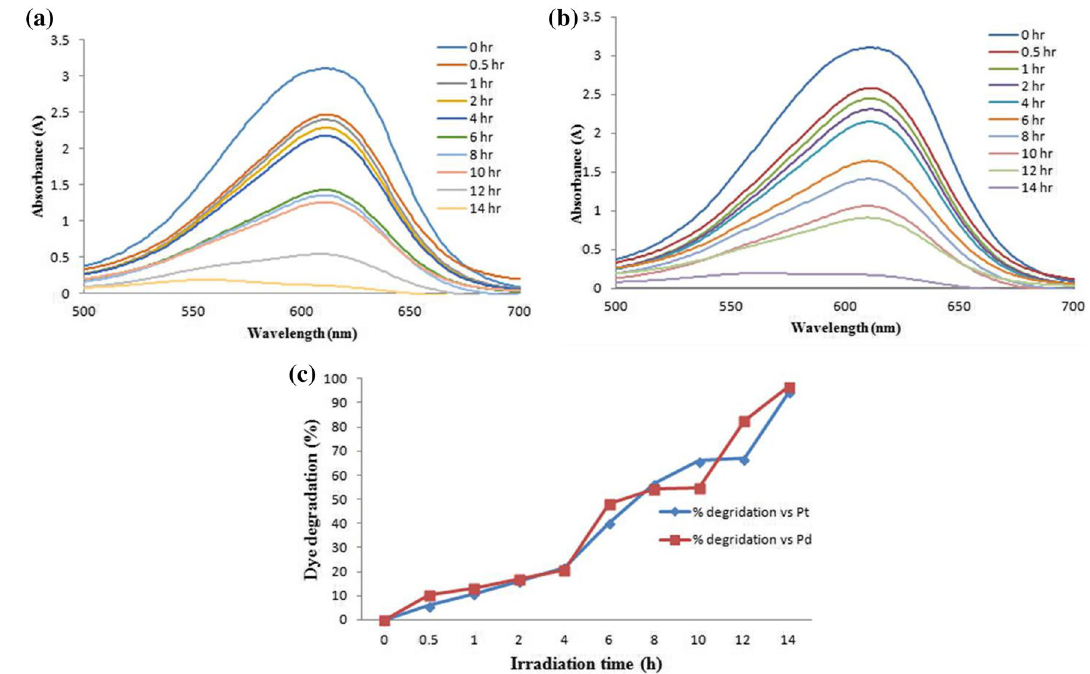
Fig. 3 a UV–VIS absorbance spectra of indigo disulfonate degraded by Pd/ZrO by Pt/ZrO 2 , c comparison of % degradation by both photocatalysts